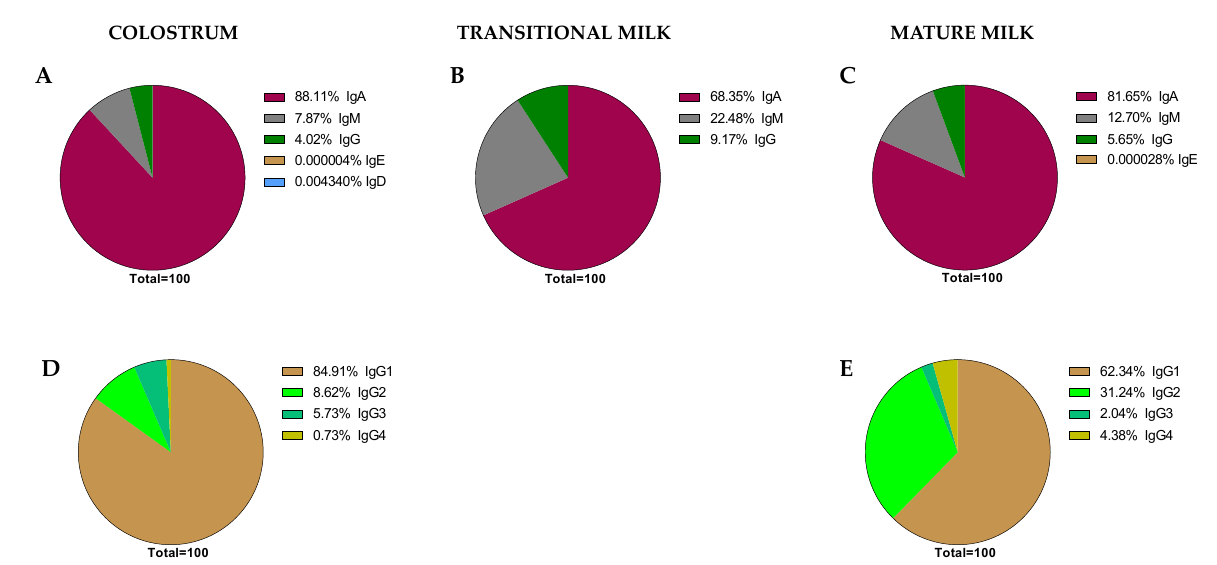
Figure 6. Global proportions from the immunoglobulin concentrations found in the literature. Proportions of Ig classes are expressed in each stage of lactation: colostrum ( A ), transition ( B ), and mature ( C ) milk. IgG subclass proportions were expressed in colostrum ( D ) and mature milk ( E ), as there are no current data for transition milk in this regard.